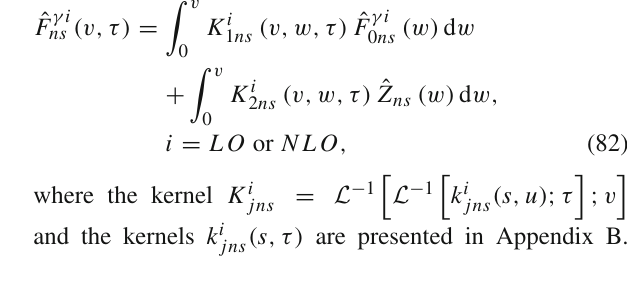
Fig. 5 A comparison of the non-singlet distribution function F